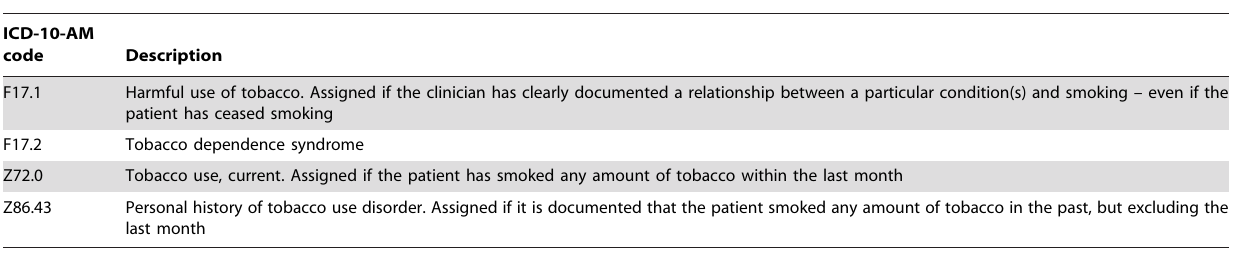
Table 2. ICD-10-AM diagnosis codes relating to